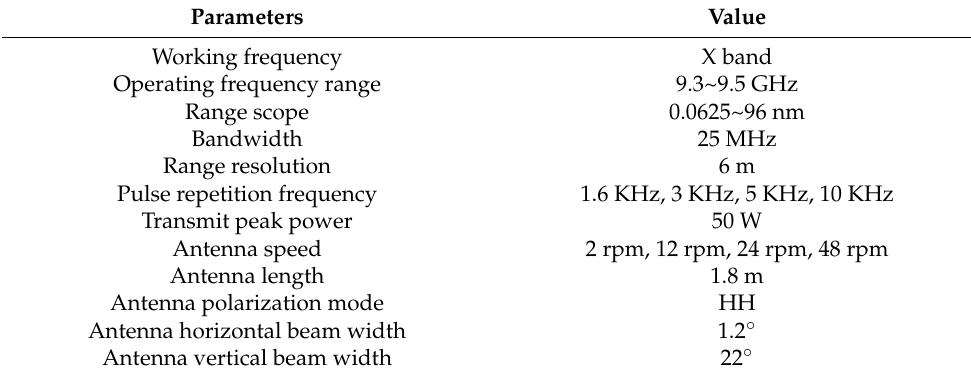
Table 1. The technical parameters of the X-band solid-state navigation radar.